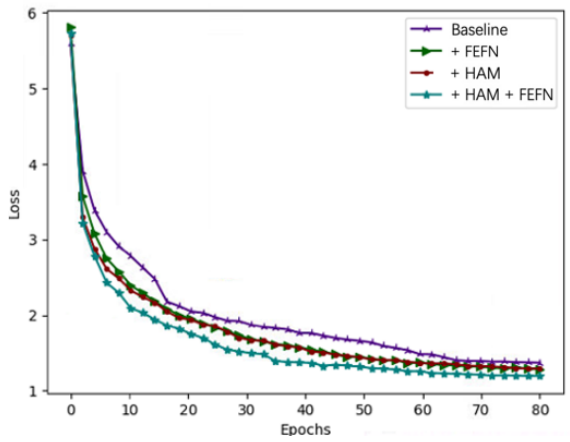
Figure 8. Training loss diagram.